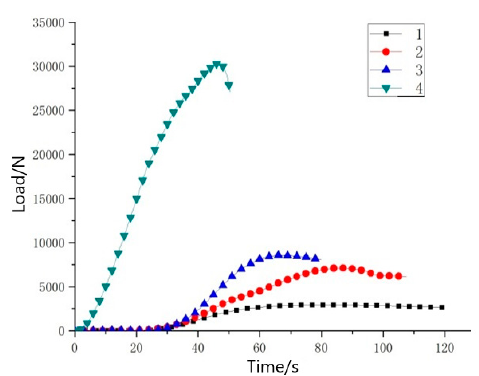
Figure 15. Sample load–time diagram.